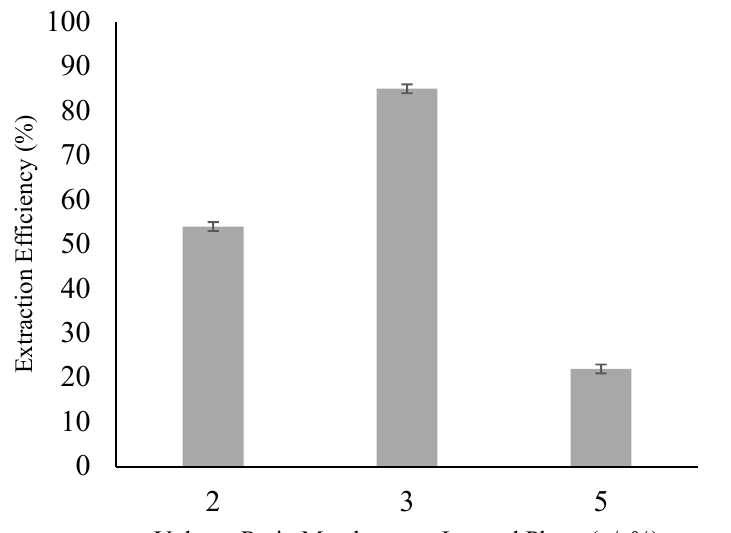
Figure 4. Effect of Volume Ratio Membrane to Internal Phase (Experimental condition: [Ammonia] = 0.1 M; [TOA] = 6 wt%; [Span 80] = 6 wt%; Organic to Internal Ratio = 3:1; Stripping Agent = Ammonia; Diluent = Kerosene).